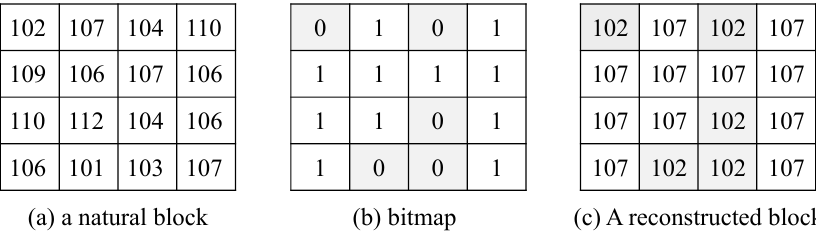
Figure 1. An example of AMBTC: ( a ) a natural block; ( b ) a bitmap block; ( c ) a reconstructed block. BM,